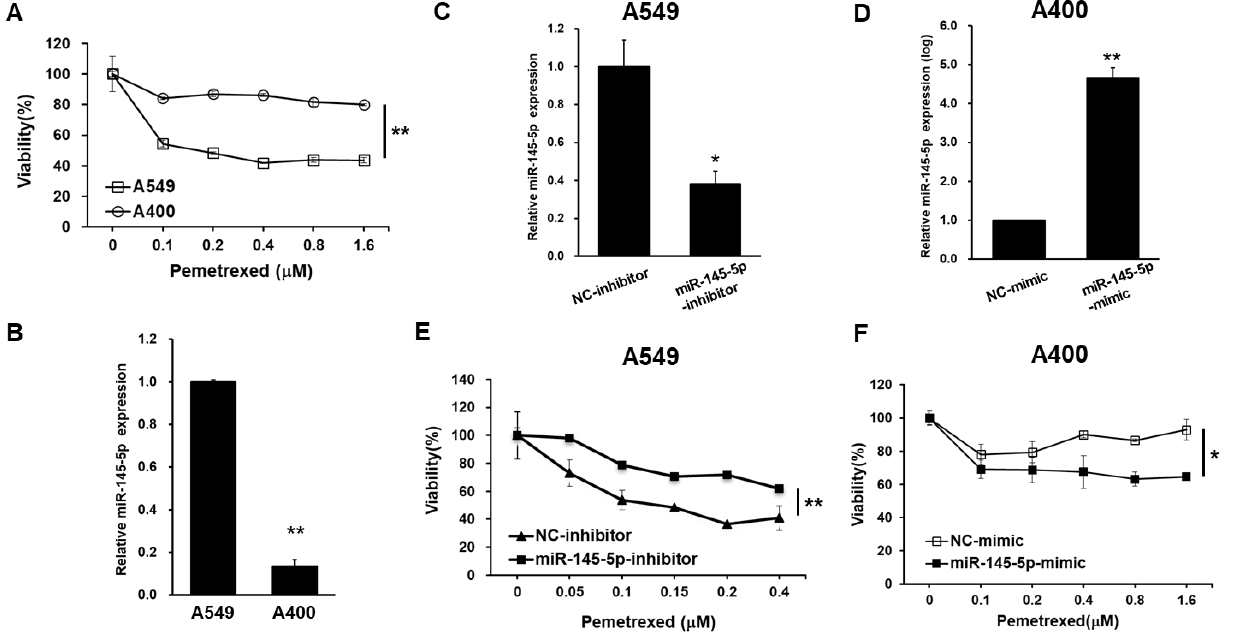
Figure 1 . The miR-145-5p expression level in NSCLC cells affects the pemetrexed sensitivity. ( A ) The differential pemetrexed sensitivity between A549 cells and the pemetrexed resistant A400 cells was determined by the MTT assay. ( B ) The miR-145-5p expression levels in the A549 or A400 cells were measured by the RT-qPCR method. ( C , E ) The miR-145-5p inhibitor or negative control (NC) inhibitor was transfected in the A549 cells. The inhibition of miR-145-5p was confirmed by the RT-qPCR method ( C ) and the effect on pemetrexed sensitivity was determined by the MTT assay ( E ). ( D , F ) Overexpression of miR-145-5p in the A400 cells was conducted by the transfection of the miR-145-5p mimic and was confirmed by thee RT-qPCR method ( D ). Pemetrexed sensitivities of the miR-145-5p mimic or negative control (NC) mimic transfected A400 cells were further measured by the MTT assay ( F ). * p < 0.05; ** p < 0.01.